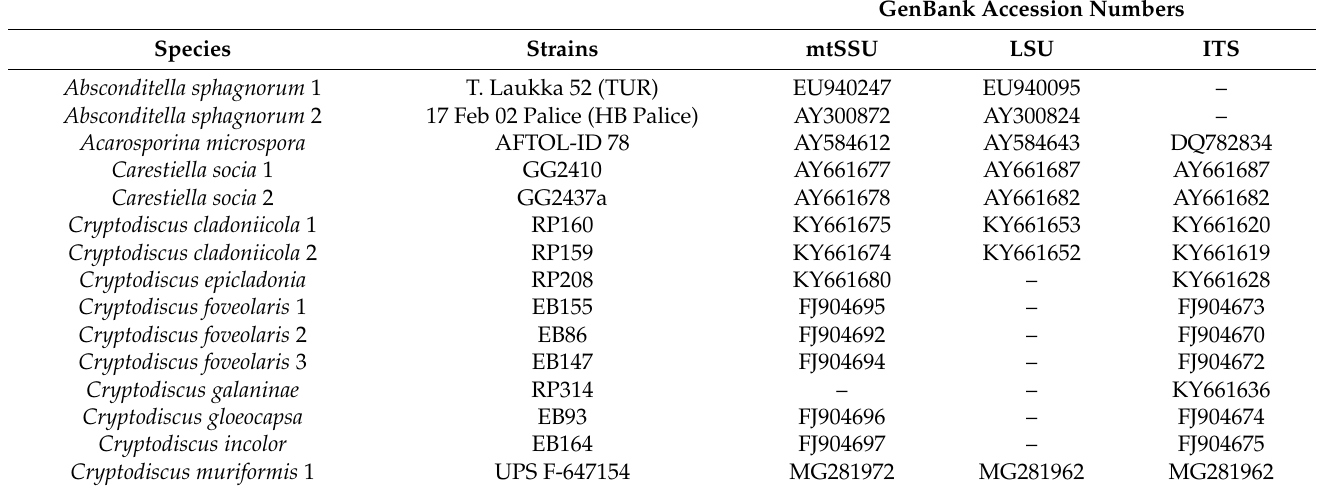
Table 1. Taxa used in this study for the analyses of combined mitochondrial small subunit spacers (mtSSU), large subunit nuclear rDNA (LSU), and internal transcribed spacers (ITS) sequence data and their GenBank accession numbers. The newly generated sequences are indicated in